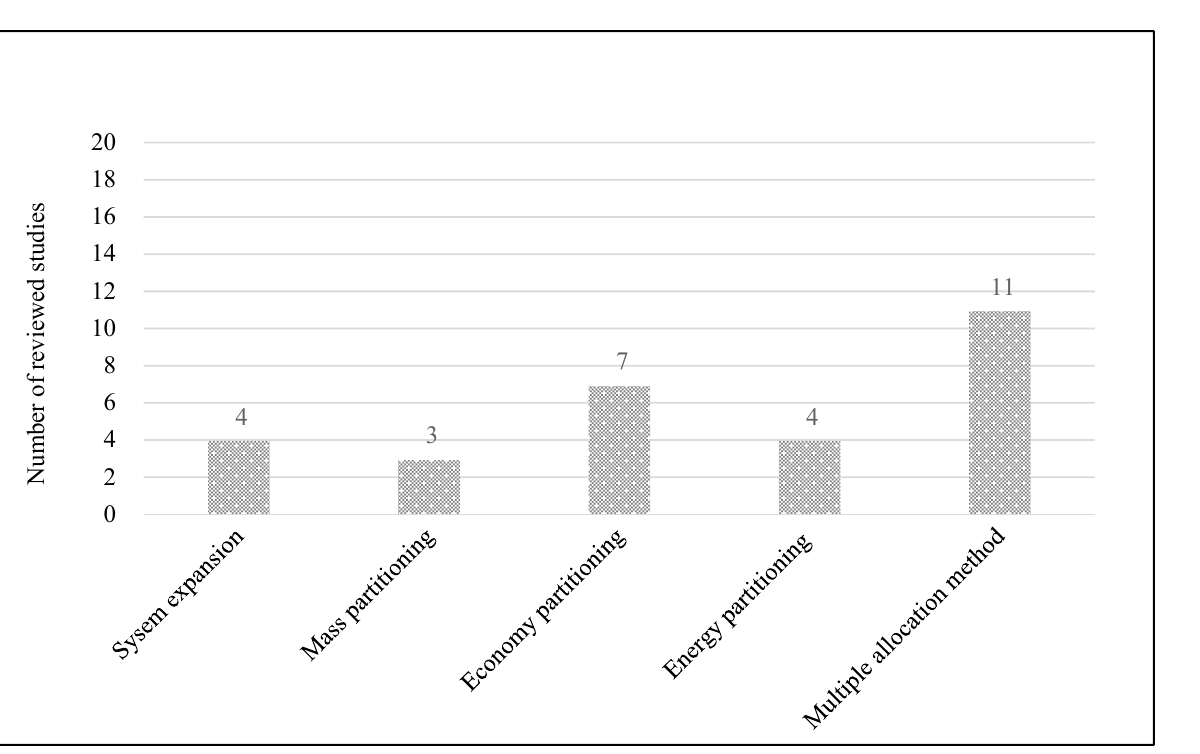
Figure 5. Different allocation methods in the reviewed papers.